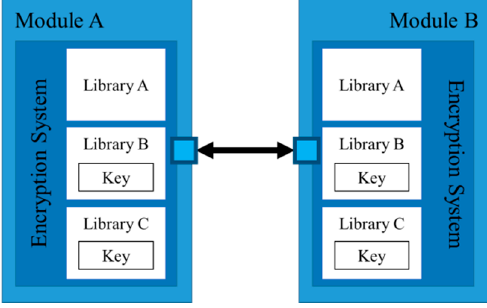
Figure 13. Data exchange command frame.